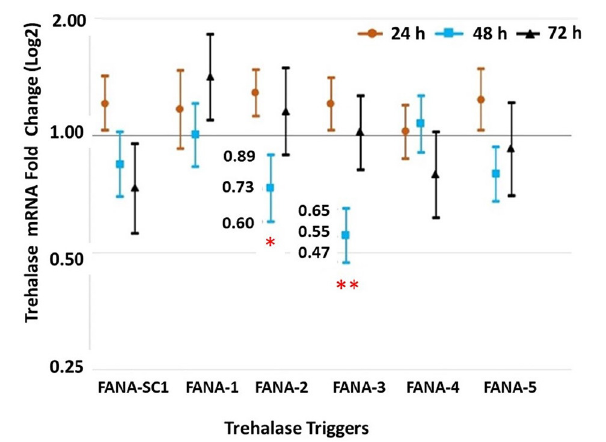
FIGURE 5 | Suppression of CLas in infected adult psyllid given a 6-day feeding access period on FANA-CLasDNAB ( replicative helicase DNA-B ), treated citrus leaf tissue, which absorbed 300 µ L of FANA at 1 µ M concentration. Only the DNAB-1 treatment showed a significant decrease in CLas titer. One way ANOVA: F (5,48) = 5.77, P < 0.001, followed by post-hoc comparison of means using Tukey test ( P ≤ 0.05). Error bars represent ± SE of the mean from six biological replicates, from three replicates. Bars with the same letter are not significantly different.